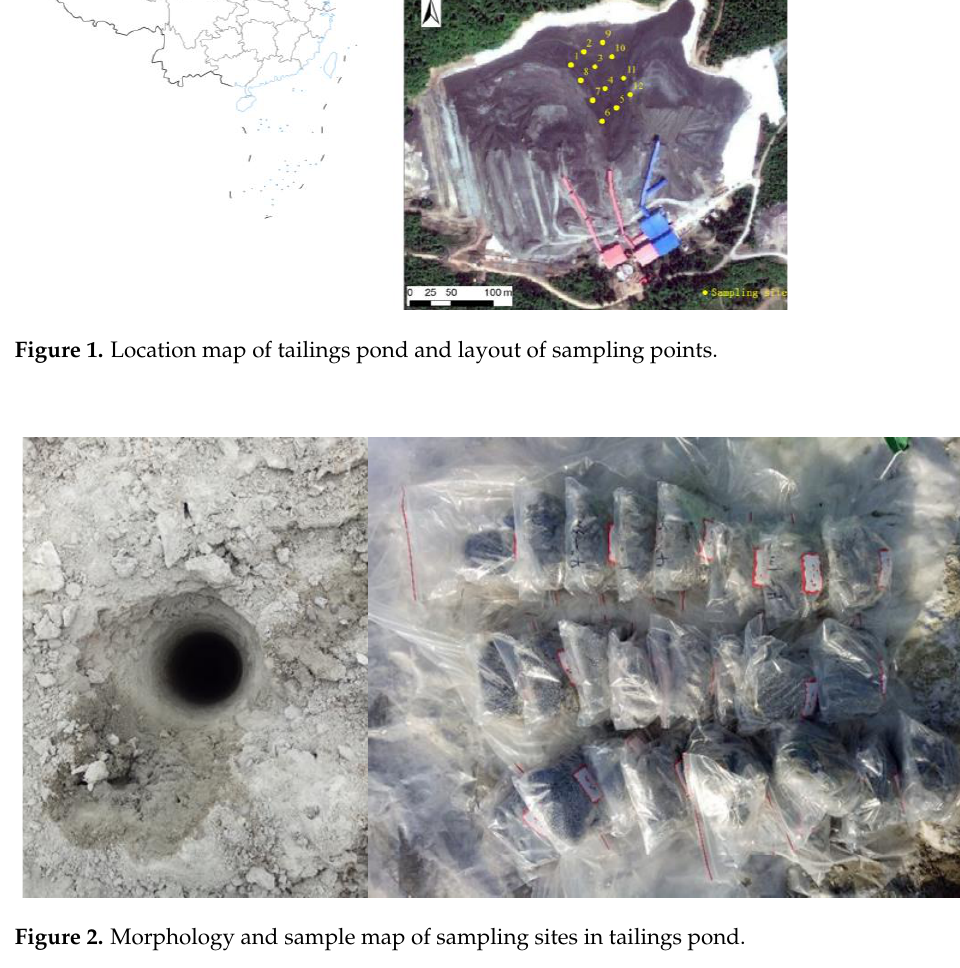
Figure 1. Location map of tailings pond and layout of sampling points.